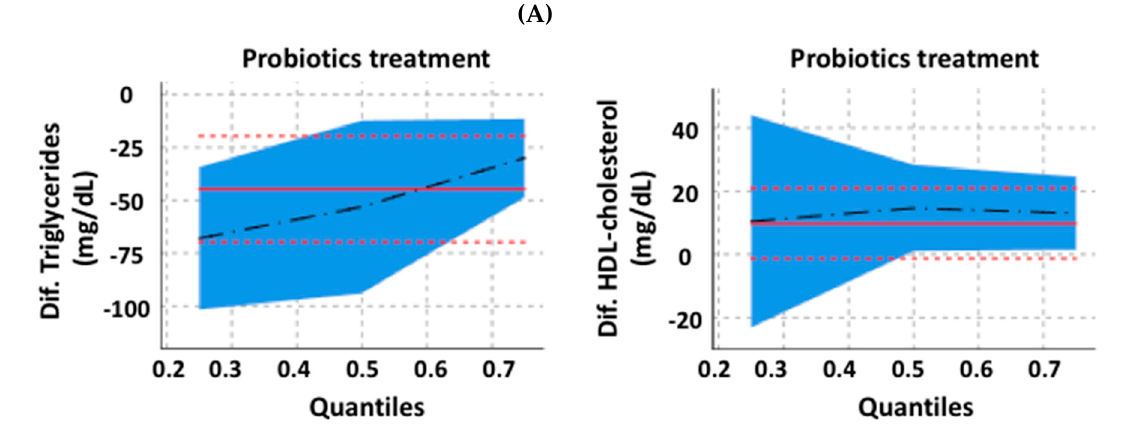
Figure 1. Associations for probiotics and the body weight, glycemia, and dyslipidemia in obese patients. By univariate linear regression, the probiotics administration was significantly associated with WL, %TWL, %EBMIL, and A1C, whereas by a quantile regression, probiotics were associated with TG and HDL ( A ). In bold, the statistically significant data. Probiotics exhibited a positive association with WL, %TWL, %EBMIL, and HDL, while it was negative with A1C and TG ( B ). The associations between variables with a normal distribution were studied by a univariate linear regression, while those with non-normal distribution were studied by a quantile regression. WL, %TWL and %EBMIL, as weight loss, percent of total weight loss, and the percentage excess BMI loss, respectively. A1C and HDL, as glycated hemoglobin, and high-density lipoprotein, respectively.